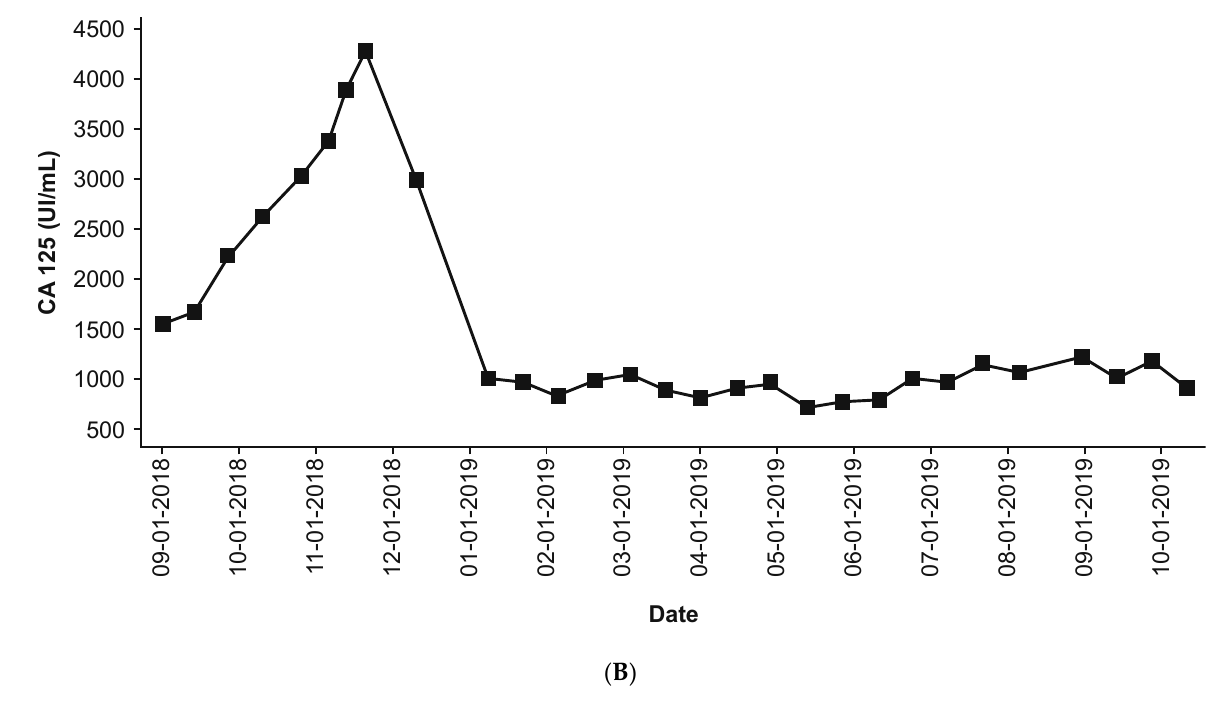
Figure 2. BMS-986158 4.5-mg treatment on schedule A in a 66-year-old female patient with serous papillary ovarian cancer. ( A ) The patient had tumors in the lymph nodes (top 2 rows), adrenal glands (third row), and peritoneum (bottom row), with tumor shrinkage observed in the lymph nodes. ( B ) The patient had elevated levels of the tumor marker cancer antigen (CA) 125 at C1D1 (5 November 2018), which decreased and stabilized. Dates are shown as month-day-year.